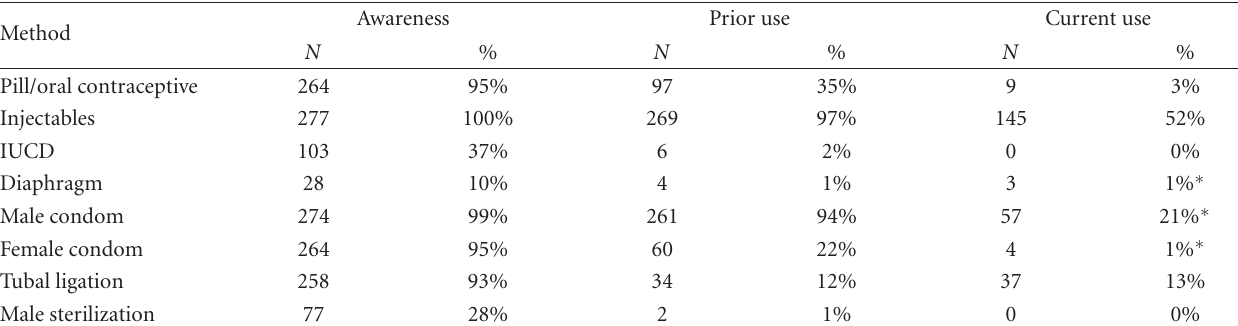
Table 2: Contraceptive method awareness and current and prior contraceptive use among HIV-positive women in Cape Town, South Africa ( N =